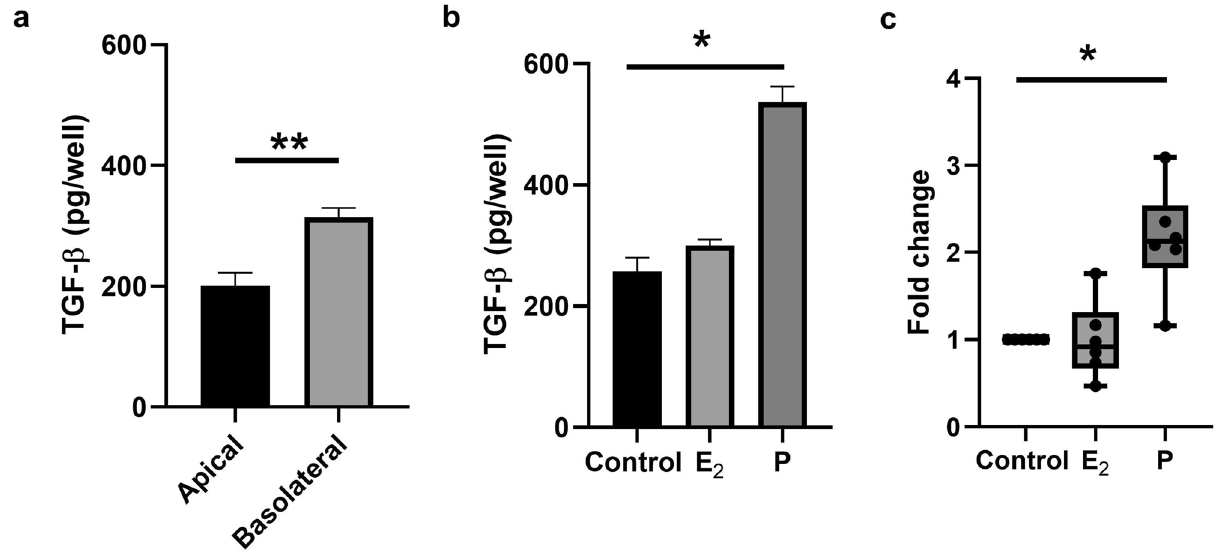
Figure 6. Constitutive production and regulation of TGFβ secretion in endometrial epithelial cells. Endometrial epithelial cells were isolated and cultured until confluence and high transepithelial resistance was reached. Polarized endometrial epithelial cells were treated with E 2 (5 × 10 −8 M) or P (1 × 10 −7 M) for 48 h. Apical and basolateral conditioned media (CM) were collected and assayed total TGFβ by ELISA. ( a ) Level of total TGFβ secreted following 48 h accumulation of constitutive apical and basolateral (n = 14). ( b ) Representative experiment showing the basolateral secretion of TGFβ by polarized endometrial epithelial cells following treatment with E 2 or P for 48 h. ( c ) Graph represents the fold change in total TGFβ in basolateral CM following E 2 or P treatment compared with untreated controls (n = 6). The mean and SEM ( a and b ) and Min to Max ( c ) are shown. * P < 0.05; ** P < 0.01; Wilcoxon matched-pairs signed rank test ( a ) and Friedman test with Dunn’s multiple comparisons test ( b and c